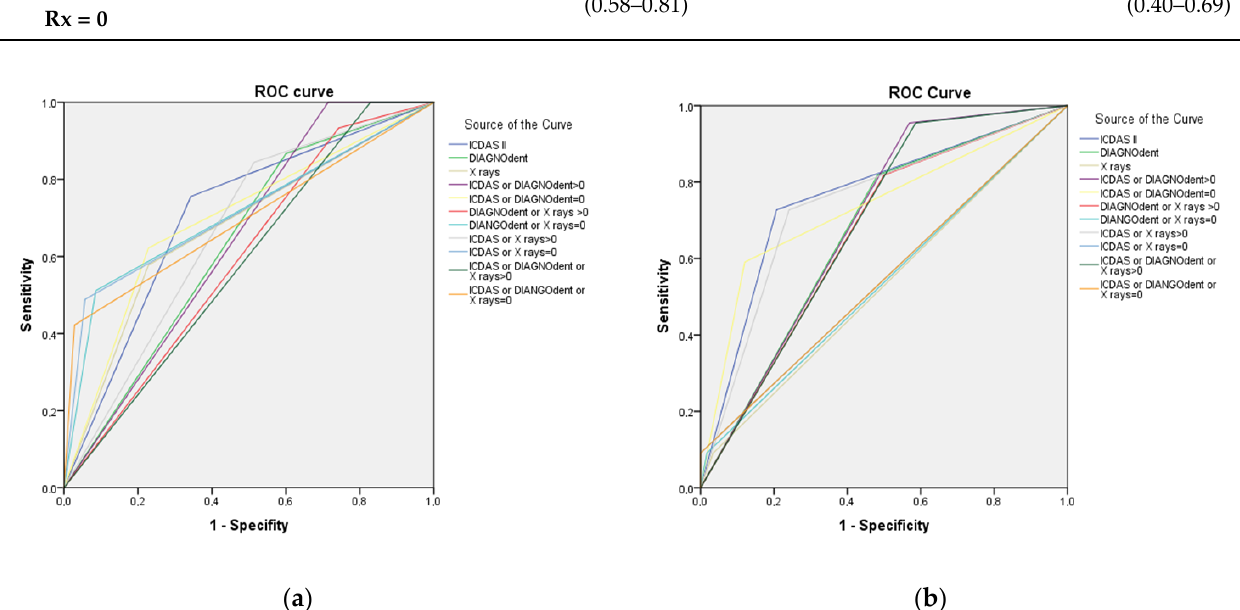
Figure 1. ROC curve for the diagnostic validity of the different methods vs. histology in lesions limited to enamel ( a ) or dentin ( b ).